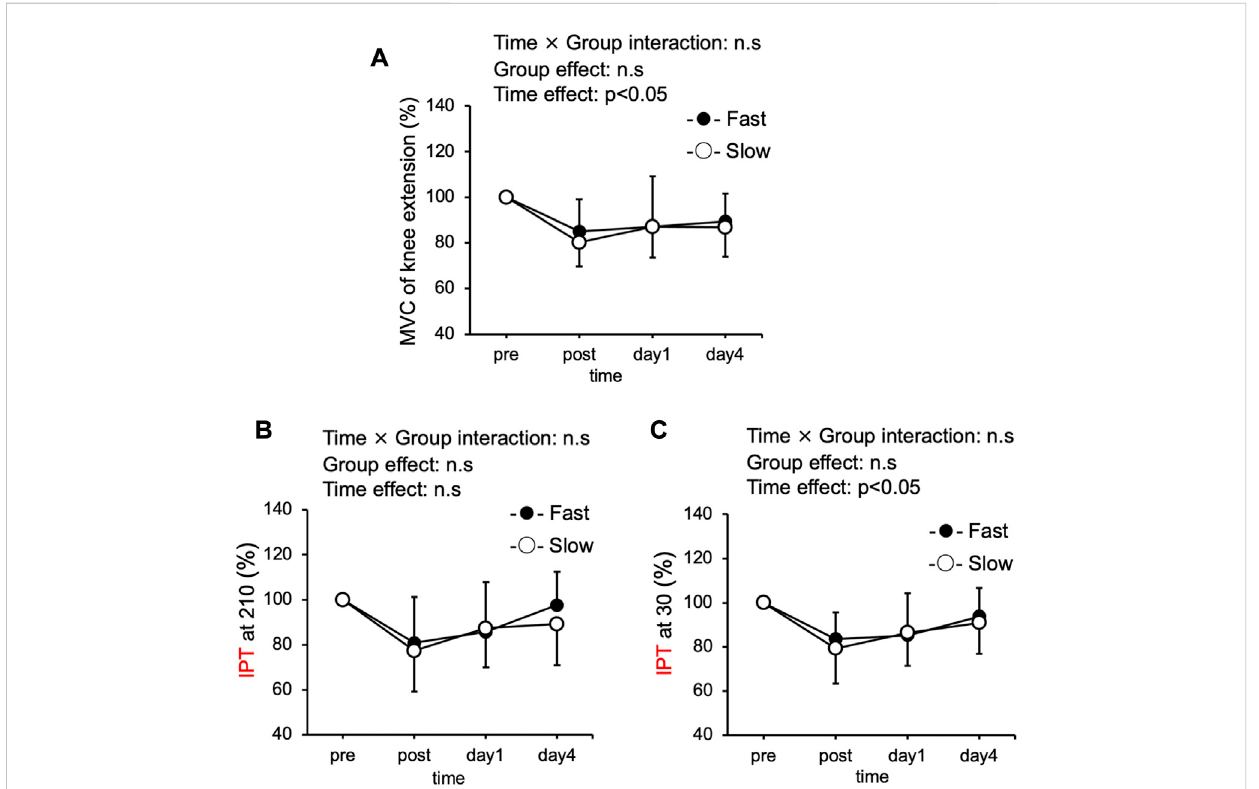
FIGURE 1 Changes (mean ± SD) in maximal voluntary isometric contraction (MVC) torque of knee extension (A) , and isokinetic pedaling peak torque (IPT) torque ofpedalingat210 ° /s (B) ,and 30 ° /s (C) ,before (pre),immediately after (post), 1 day, and4daysafter exercise intheslowvelocitysession(Slow) and fast velocity session